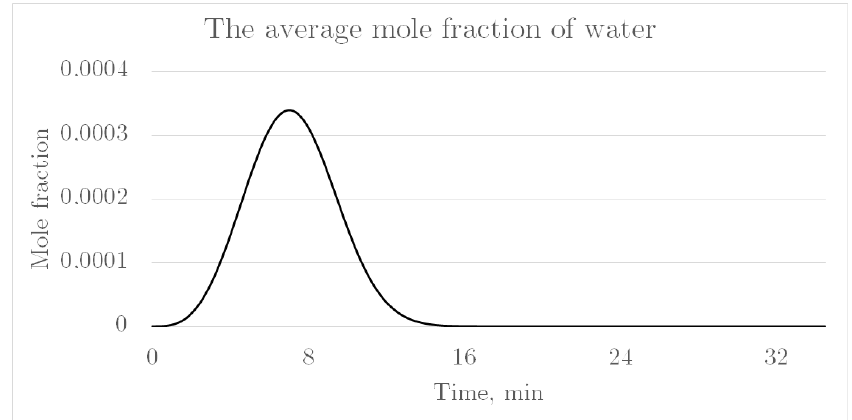
Figure 11. Dynamics of the average molar fraction of water in the reaction mixture in the pores of the catalyst grain.